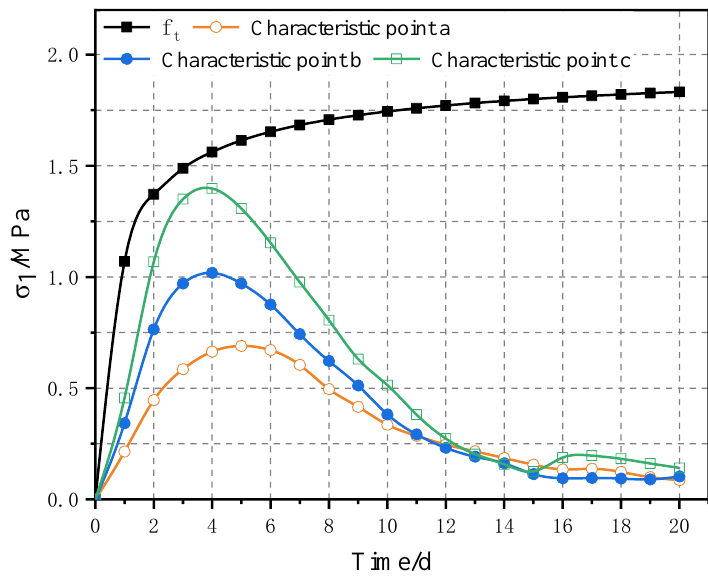
Figure 7. Stress duration curves of characteristic points a, b and c.